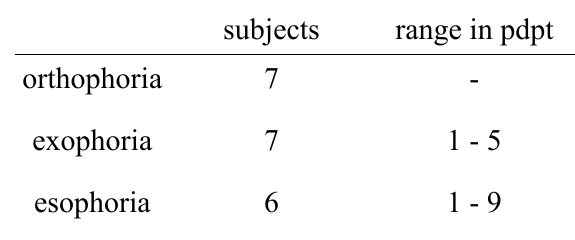
Table 3: Distribution of distance phoria (6m)